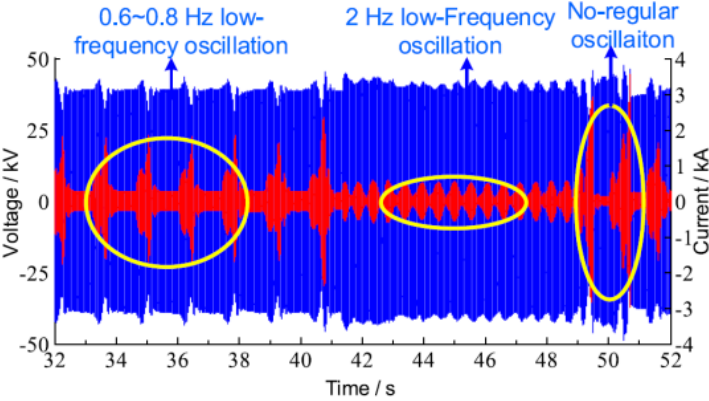
Figure 5. Measured various types of LFO phenomena [64].